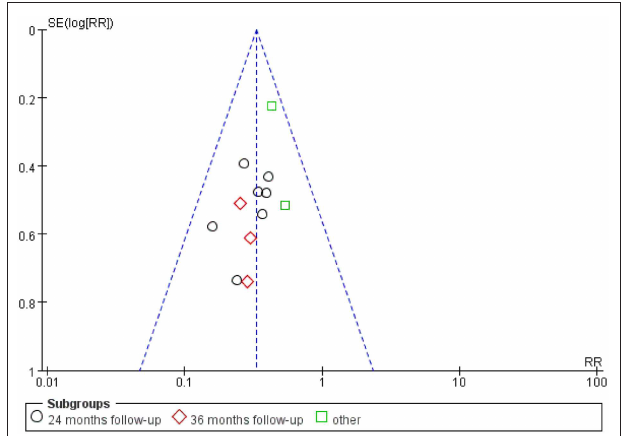
FIGURE 4 | Funnel plot of included studies.